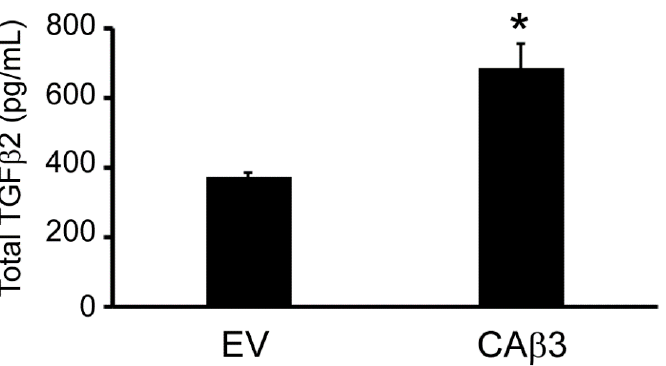
Figure 11. CA β 3 cells secrete more TGF β 2 than EV cells . ELISA data for total TGF β 2 in the medium